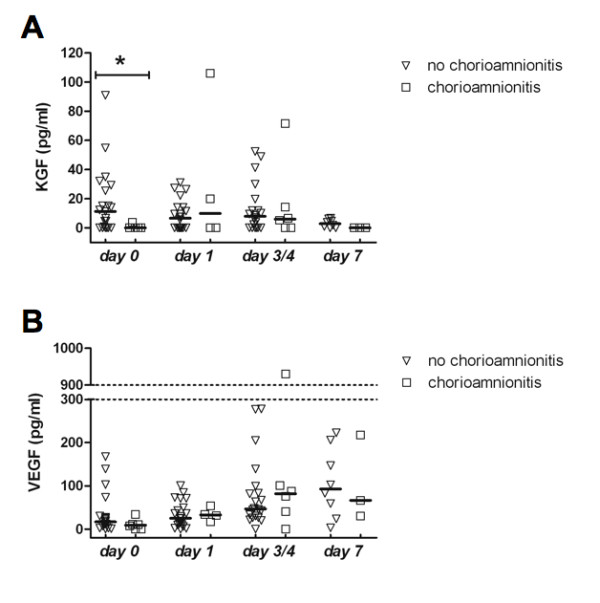
Keratinocyte growth factor (KGF) and vascular endothelial growth factor (VEGF) levels in bronchoalveolar lavage fluid (BALF). KGF (A) and VEGF (B) levels in bronchoalveolar lavage fluid (BALF) obtained at different postnatal days from patients with and without chorioamnionitis. Points represent individual BALF growth factor concentrations, horizontal lines represent medians (*p < 0.05).